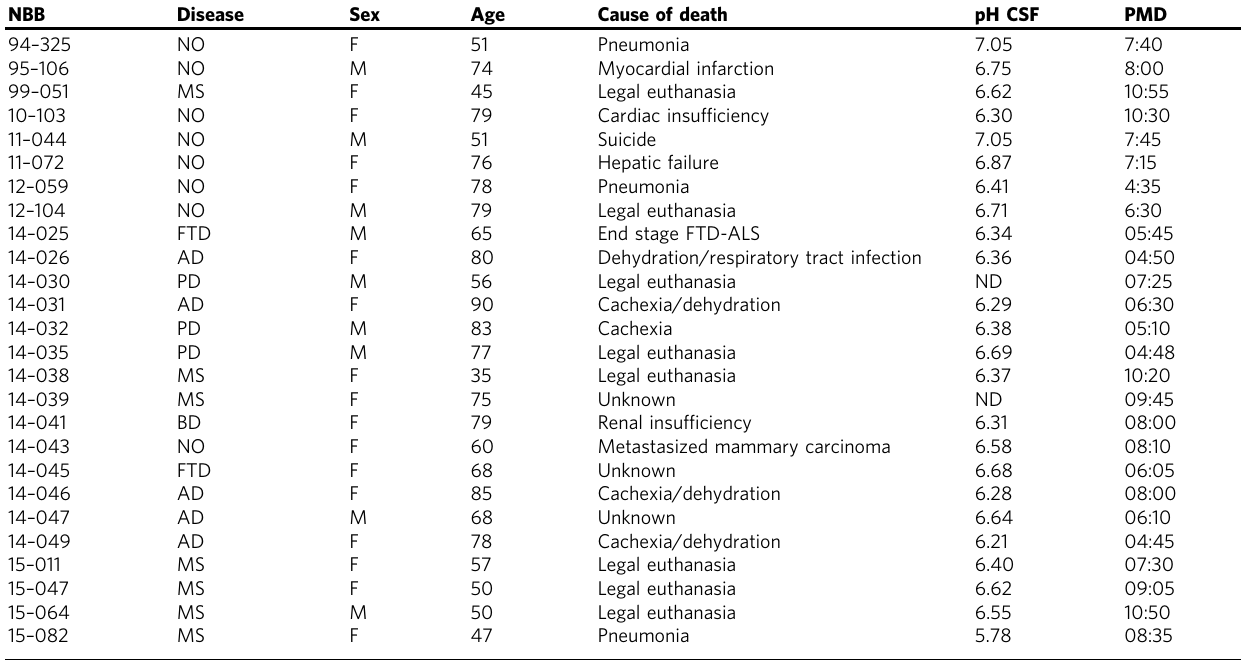
Table 1 Brain donor characteristics NBB